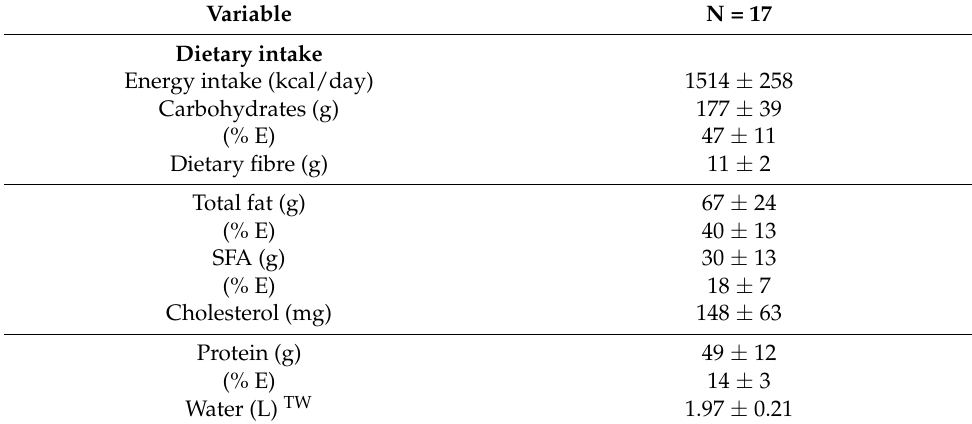
Table 4. Dietary intake (mean ±